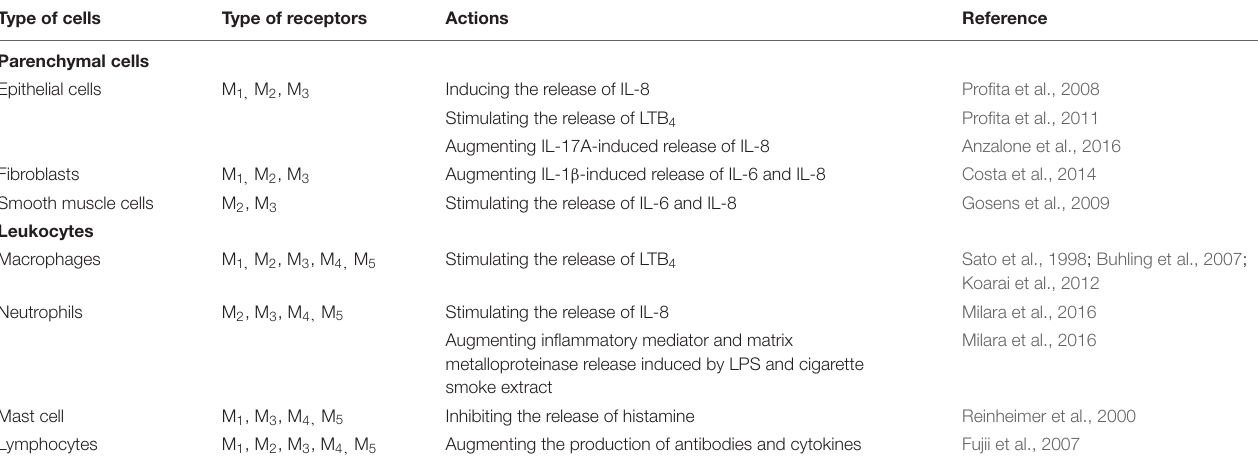
TABLE 1 | Pro-inflammatory effects of ACh on parenchymal and leukocytes via muscarinic